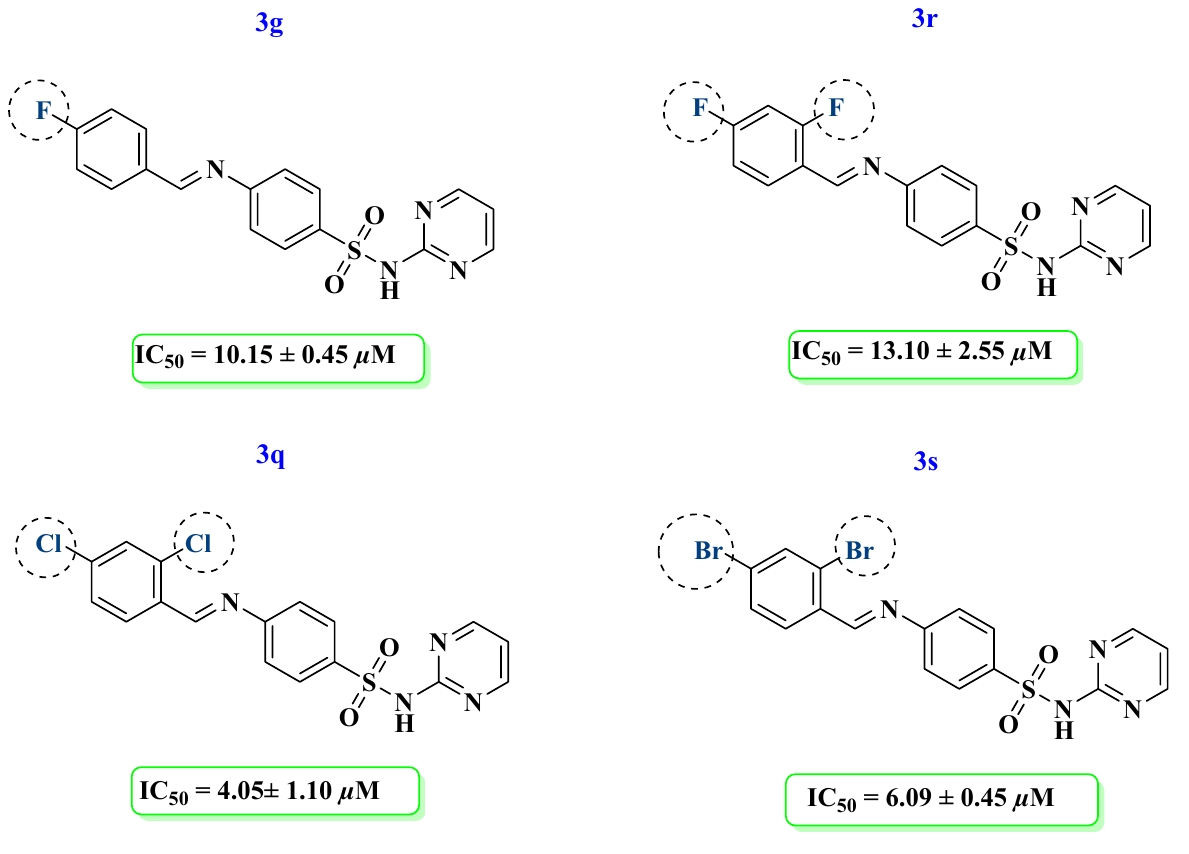
Figure 5. Structure–activity relationship of compounds 3g, 3q, 3r,